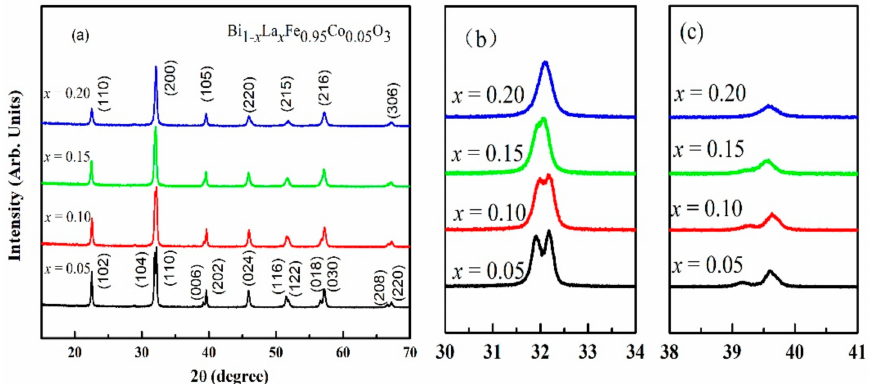
Figure 1. ( a ) X-ray diffraction patterns of Bi 1 − x La x Fe 0.95 Co 0.05 O 3 ( x = 0.05, 0.10, 0.15, and 0.20) nanoparticles. Enlarged pattern of the diffraction peaks at ( b ) 2 θ = 32 ◦ and ( c ) 2 θ = 39 ◦ .